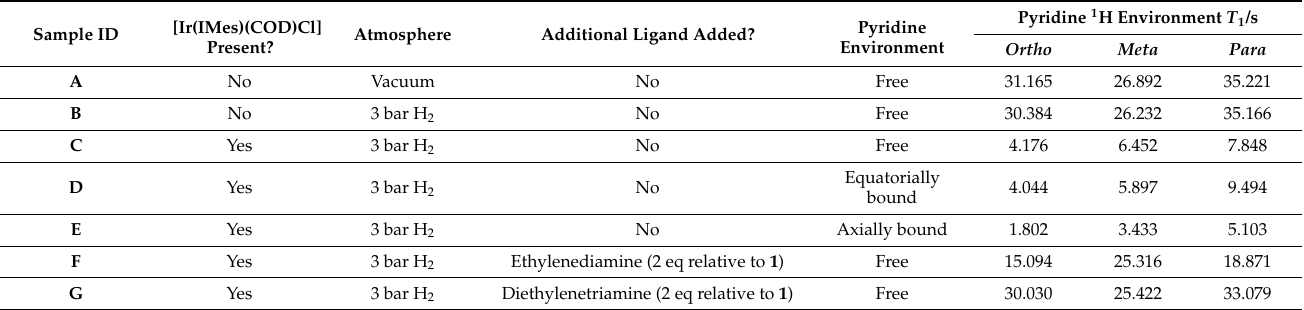
Table 1. Pyridine T 1 values at 9.4 T demonstrating the effect of changing environment with and without 1 , ethylenediamine, and diethylenetriamine present. Sample ID from this table is utilized in the discussion.